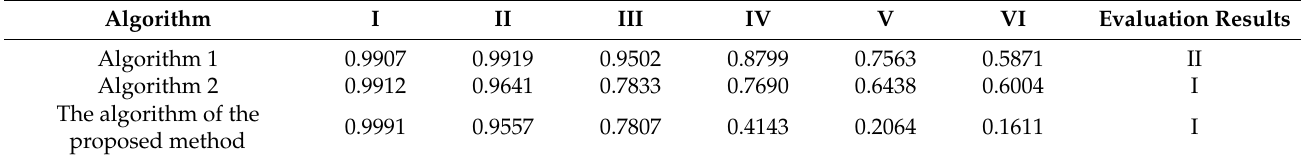
Table 11. Evaluation results of different algorithms in the polishing stage.